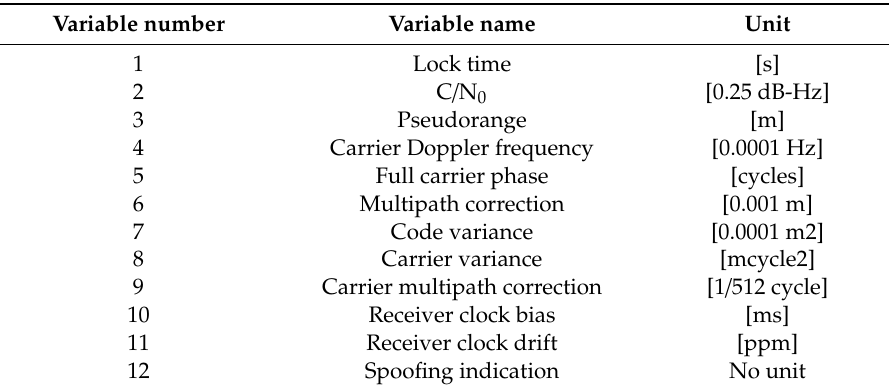
Figure 4. Correlation matrix (adapted from [13]). Table 1. List of